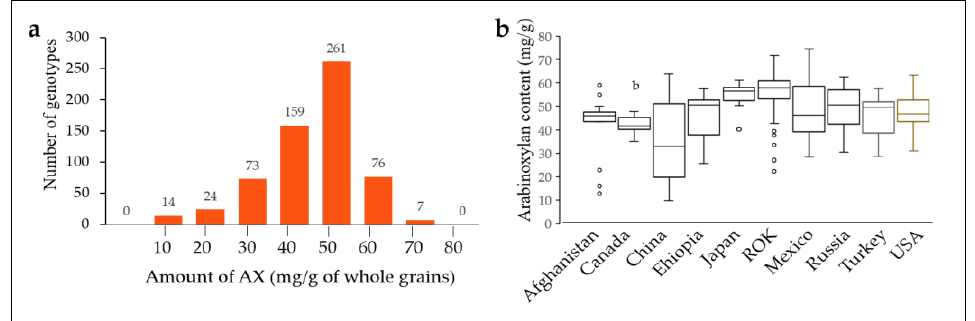
Figure 2. Arabinoxylan (AX) level evaluated in a collection of 562 Triticum aestivum genotypes. AX level distribution diagram ( a ) and AX level by country ( b ). ROK, Republic of Korea.